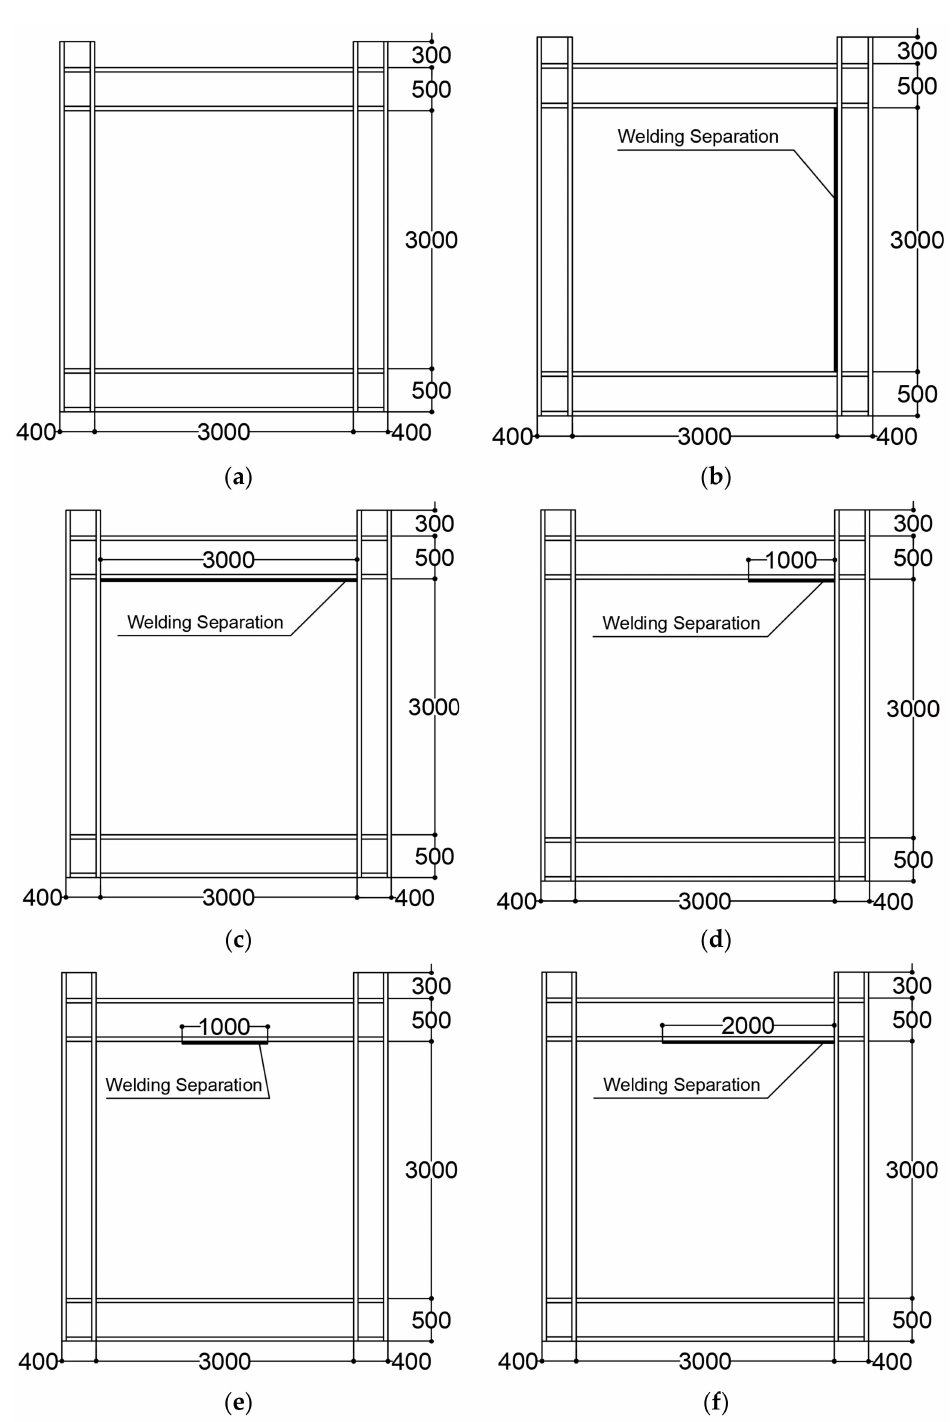
Figure 2. Details of plate welding separation characteristics; ( a ) SPt5; ( b ) PS1; ( c ) PS2; ( d ) PS3; ( e ) PS4; ( f ) PS5 (dimensions in